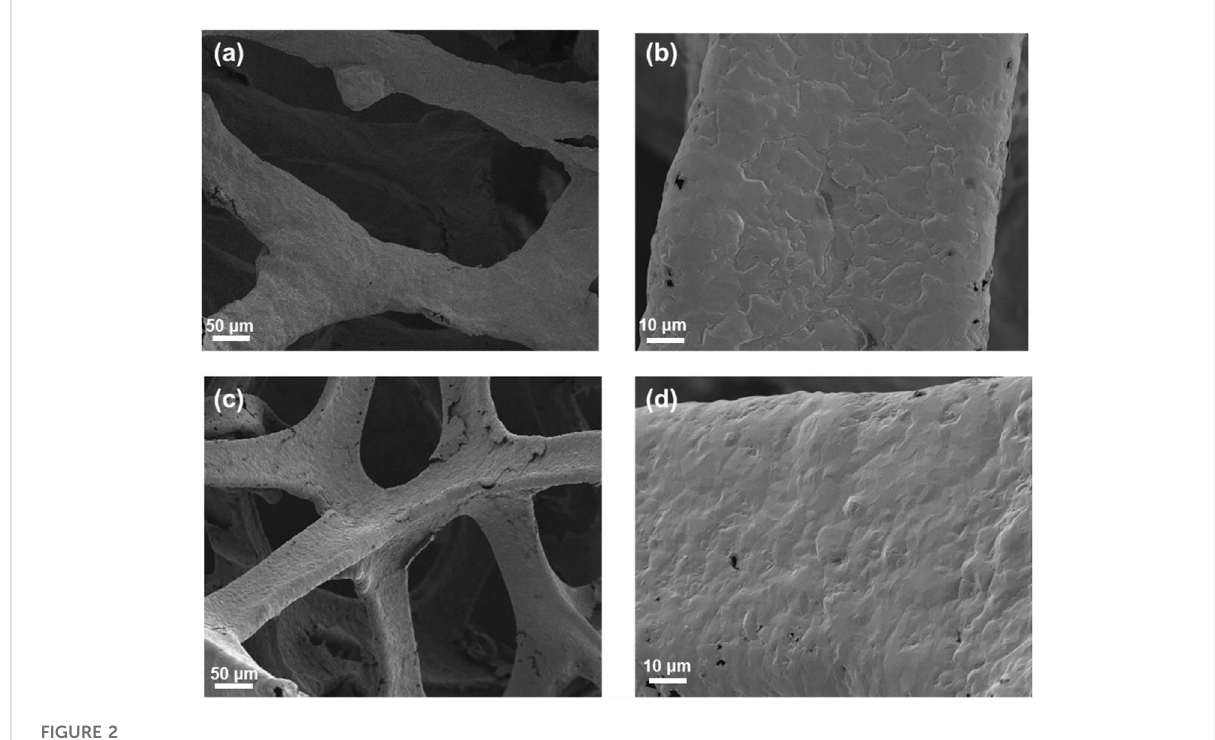
FIGURE 2 SEM images of 3DG (A,B) and p-3DG (C,D) at different magni fi